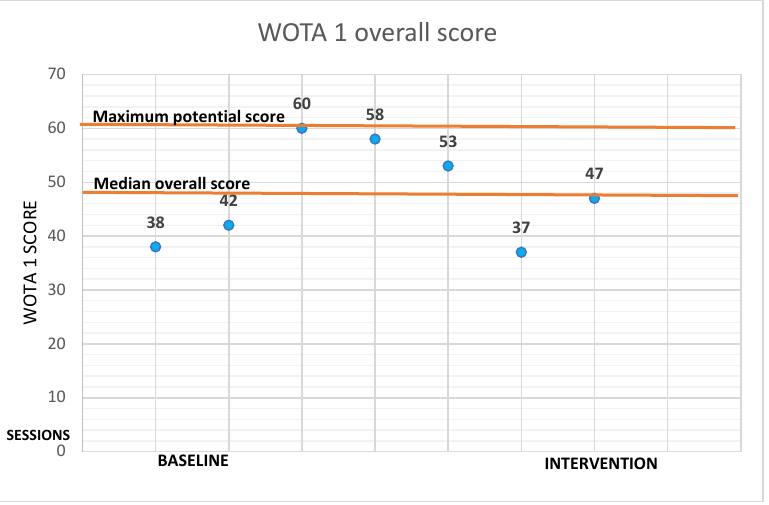
Figure 8. Maximum potential score = 60; median scores of all overall participant scores = 47. P1 = Participant 1, P2 = Participant 2, P3 = Participant 3, P4 = Participant 4, P5 = Participant 5, P6 = Participant 16, P7 = Participant 7. Table 3. Nine-week session outcomes via the WOTA 1 [27].